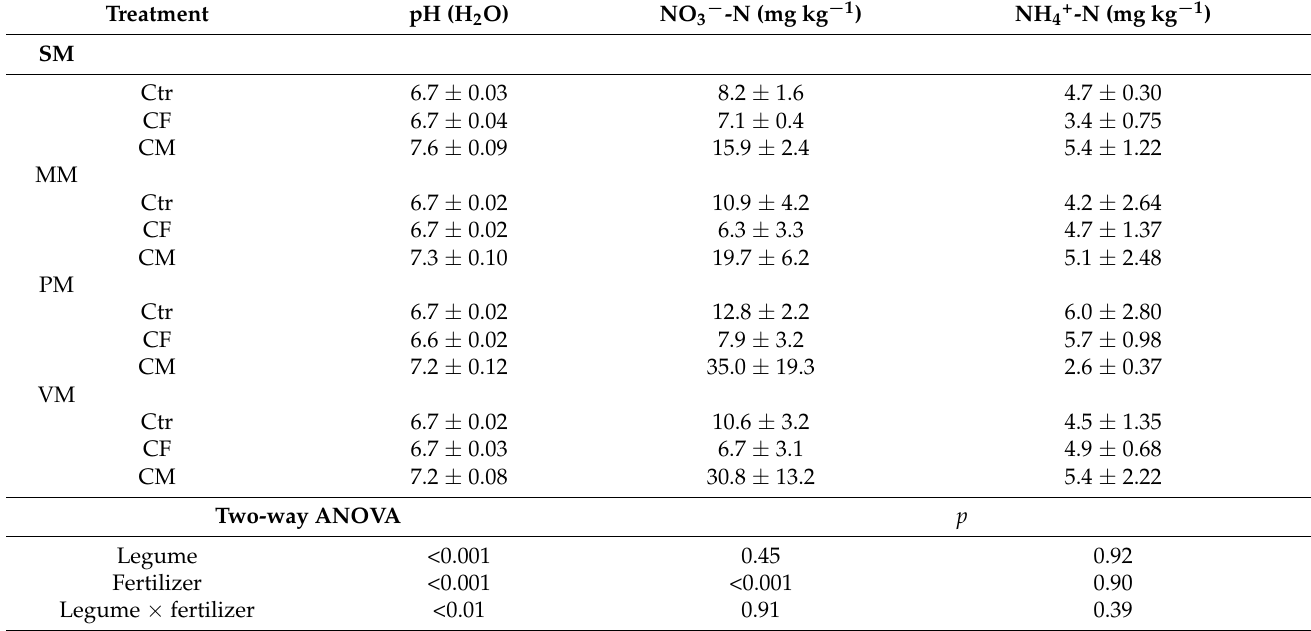
Table 3. Soil pH, nitrate, and ammonium content after plant